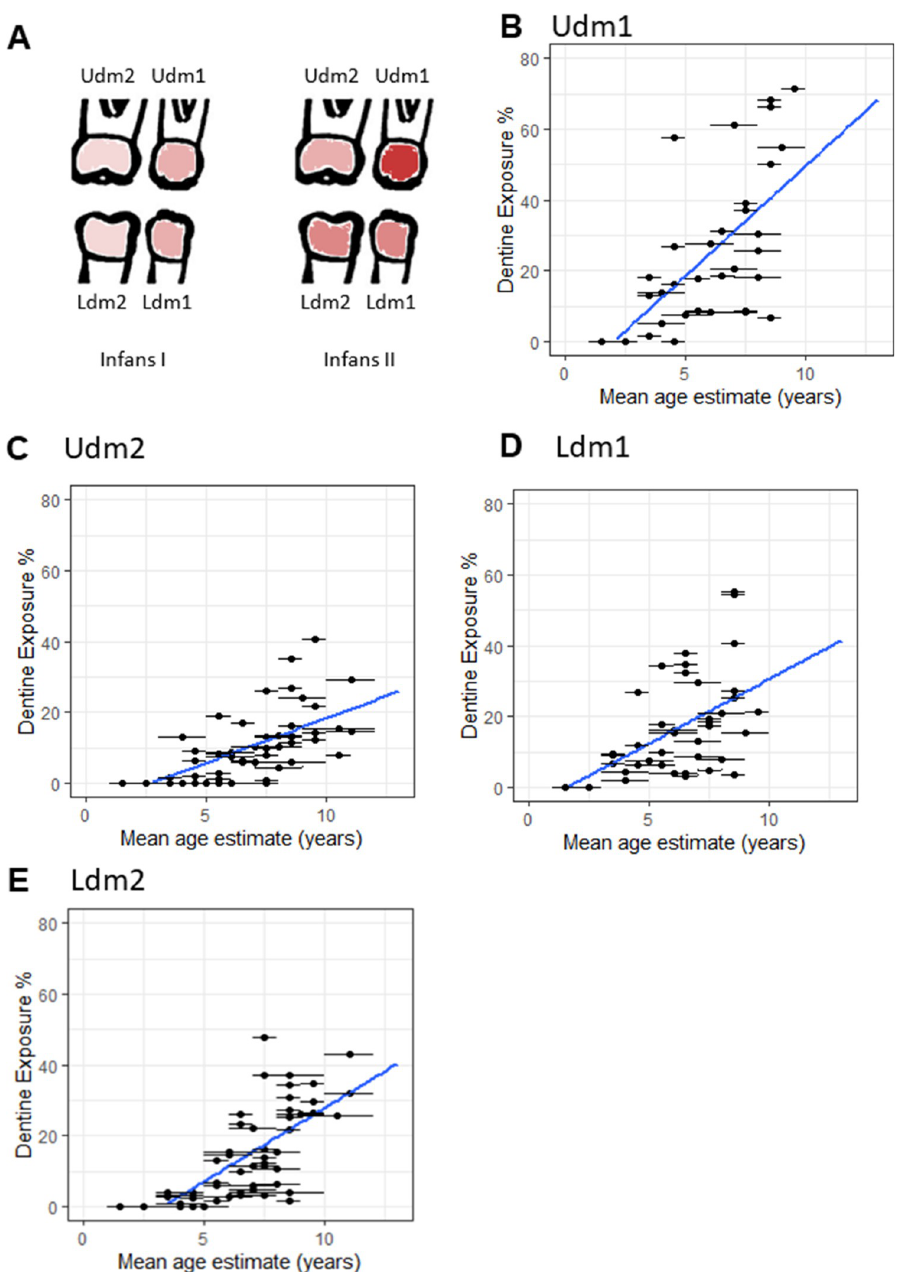
Fig 3. Dentine exposure on deciduous molars varies depending on the position of the molar. (A) Illustration of the distribution of dentine exposure among deciduous molars (darker red signifies a higher mean percent (%) of exposed dentine on the occlusal surface). (B) Scatterplot of Udm1 the area of dentine exposure as a % of the occlusal surface by mean estimated age with a linear model. (C) Scatterplot of Udm2 the area of dentine exposure as a % of the occlusal surface by mean estimated age with a linear model. (D) Scatterplot of Ldm1 the area of dentine exposure as a % of the occlusal surface by mean estimated age with a linear model. (E) Scatterplot of Ldm2 the area of dentine exposure as a % of the occlusal surface by mean estimated age with a linear